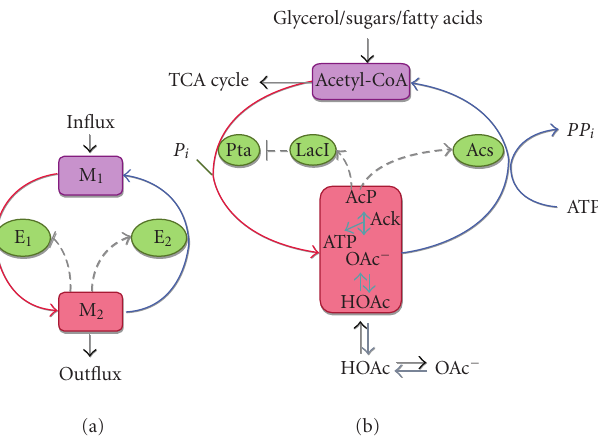
Figure 3: Conceptual design and biological implementation of the oscillatory circuit metabolator in Fung et al. [6]. (a) Conceptual design. The metabolator consists of two interconverting metabolite pools M 1 and M 2 ; their interconversions are catalyzed by the enzymes E 1 and E 2 . Dashed lines indicate positive (arrow) and negative (blunt bar) regulation by M 2 at the transcriptional or translational level; the accumulation of M 2 represses E 1 and induces E 2 . The circuit functions as follows. Influx into the circuit (from upstream processes) increases the concentration of M 1 , which is converted to M 2 by E 1 . Initially the concentration of M 1 is high and M 2 is low. However, M 2 gradually accumulates causing E 1 to be repressed and E 2 to be induced, eventually causing a net conversion of M 2 to M 1 , which then starts a new cycle. (b) Biological implementation. The design of the metabolator was implemented using the acetate pathway in E. coli. The M 1 pool is acetyl-CoA; the M 2 pool consists of AcP, OAc − , and HOAc. Pta and Acs correspond to enzymes E 1 and E 2 . Pta converts Acetyl-CoA to AcP, and AcP is further converted to OAc − by Ack. The protonated form of OAc − (HOAc) is permeable across the cell membrane. AcP is used as a signaling molecule and functions as follows. When AcP builds up, it will activate promoter glnAp2 through phosphorylation. The promoter glnAp2 controls the expression of Acs and lac repressor (LacI), and LacI in turn represses the expression of Pta. Ack: acetate kinase; AcP: acetyl phosphate; Acs: acetyl-CoA synthetase; HOAc: protonated form of acetate; LacI: lac repressor; OAc − : acetate; Pta: phosphate acetyltransferase (adapted from Fung et al.